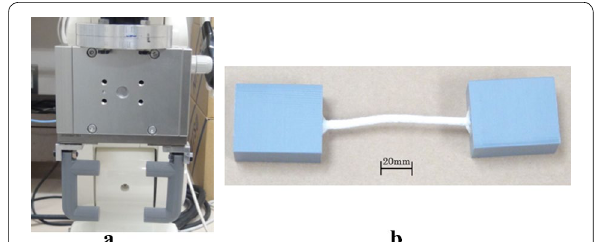
Fig. 18 Experimental equipment. a Parallel gripper and b object model